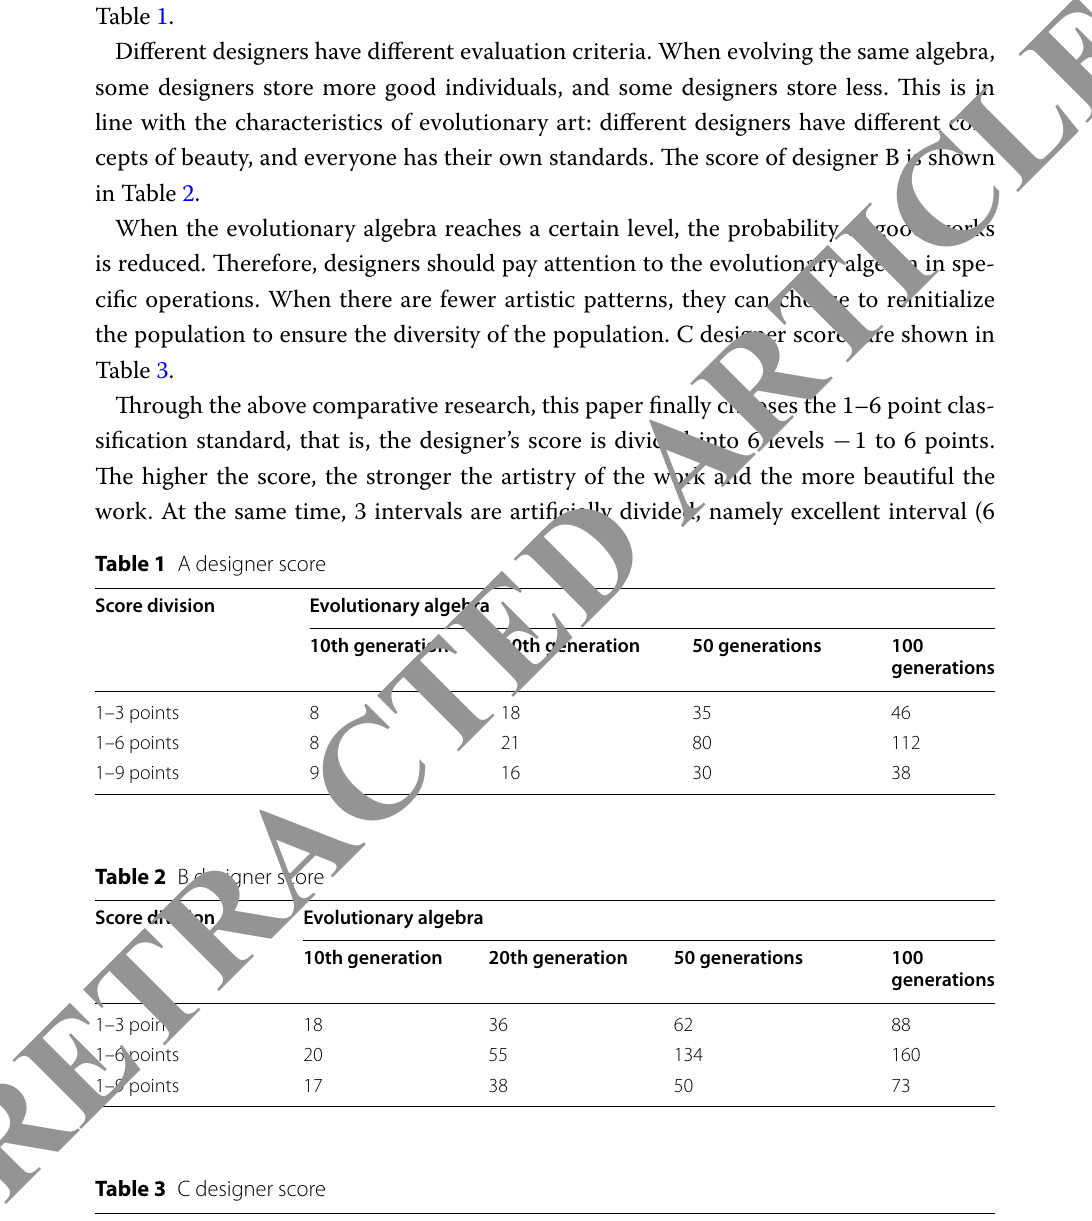
Score division Evolutionary